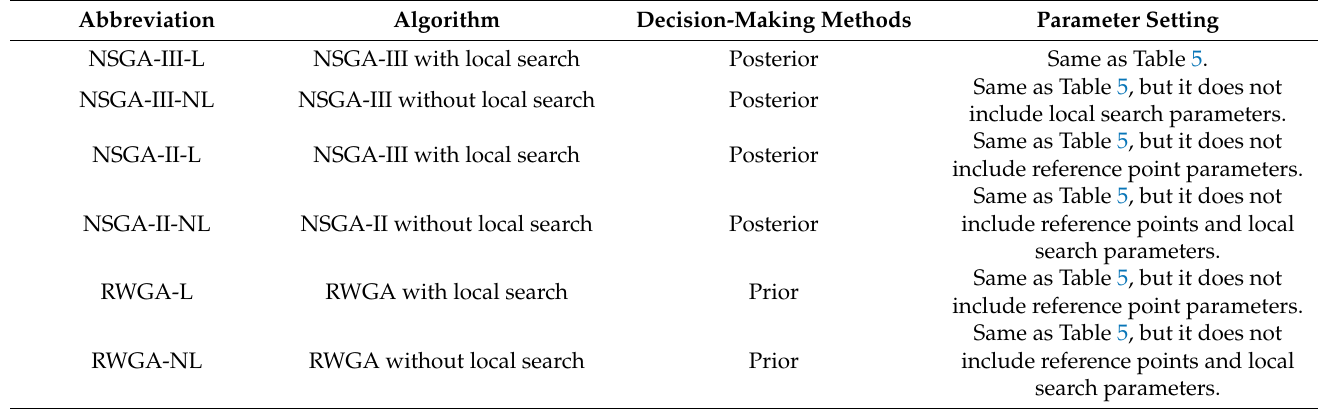
Table 8. Algorithms used in the comparative